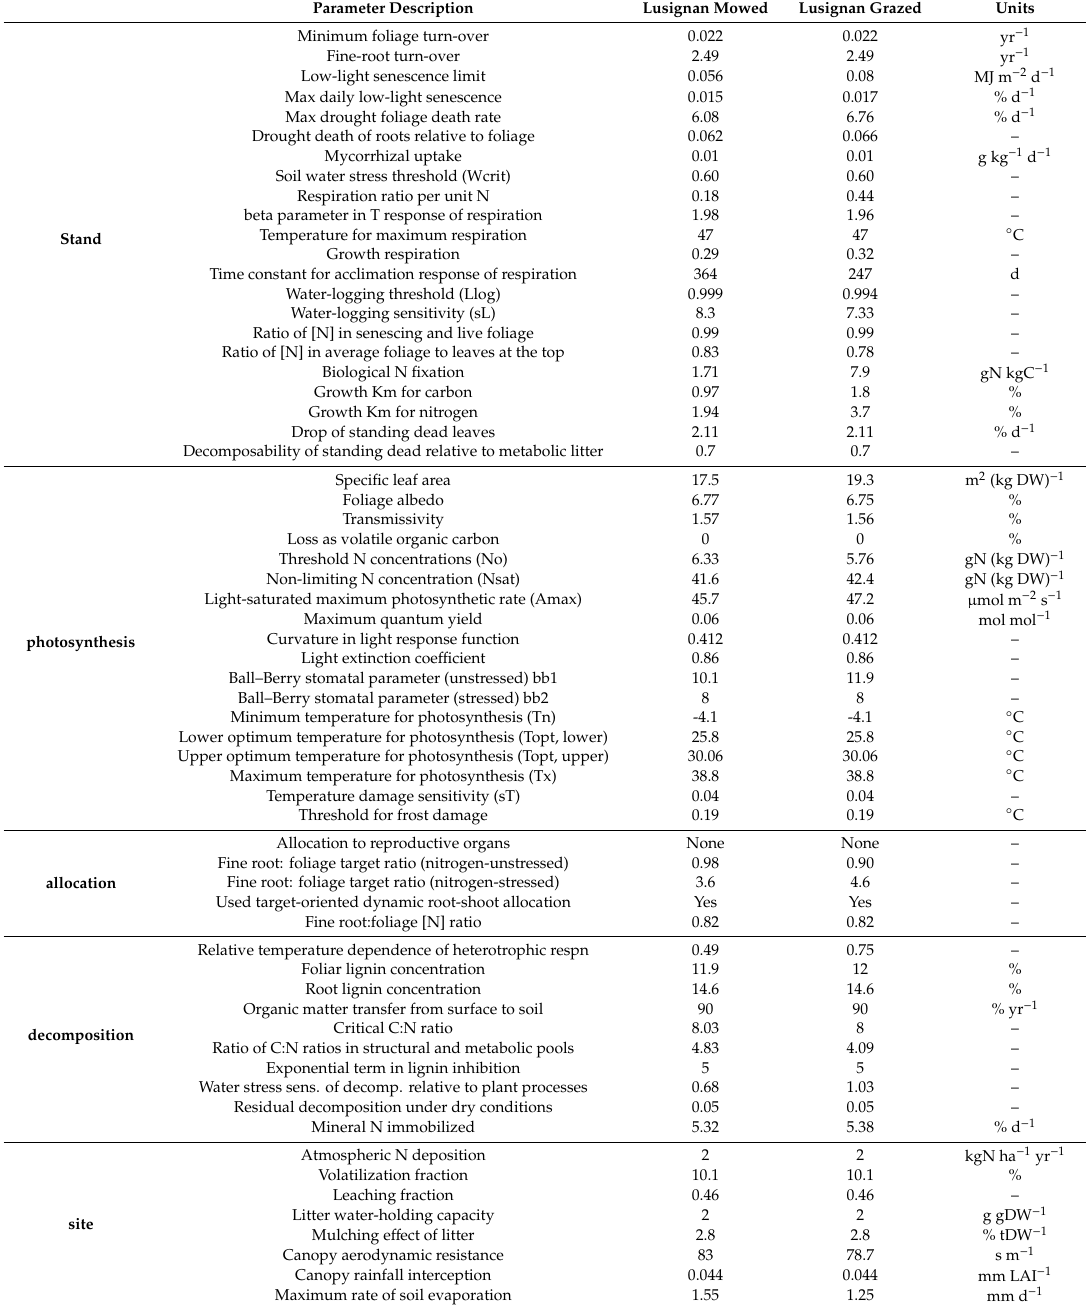
Table A2. Main model parameters values used to simulate mowed and grazed grasslands after CenW